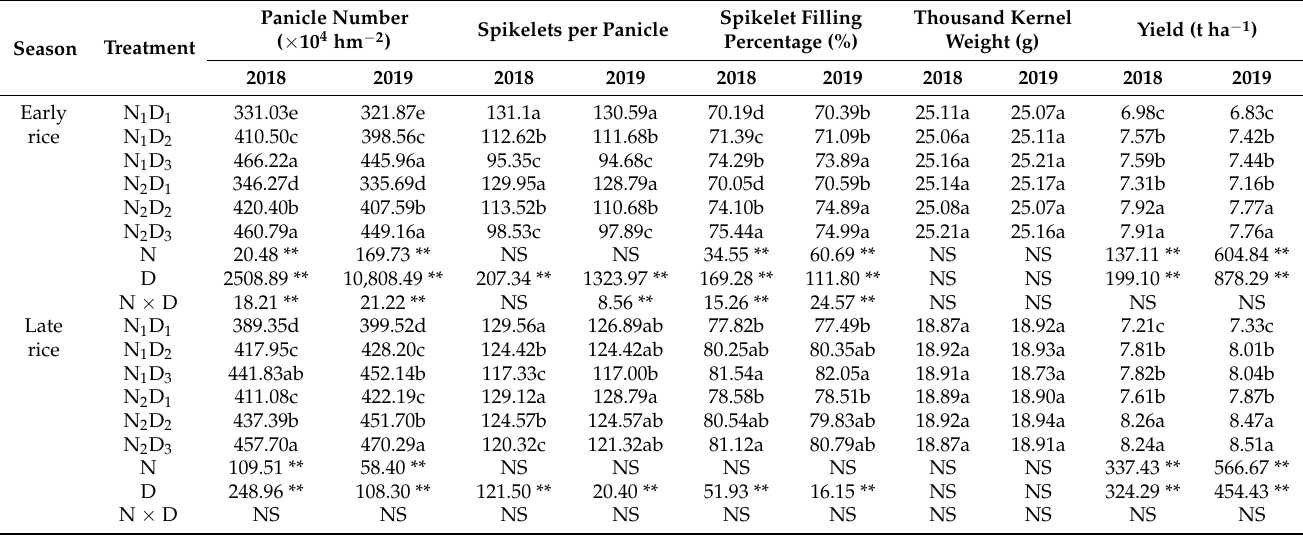
Table 1. Double cropping rice yield and yield compositions response to the nitrogen (N) rate and plant density at Shanggao in 2018 and